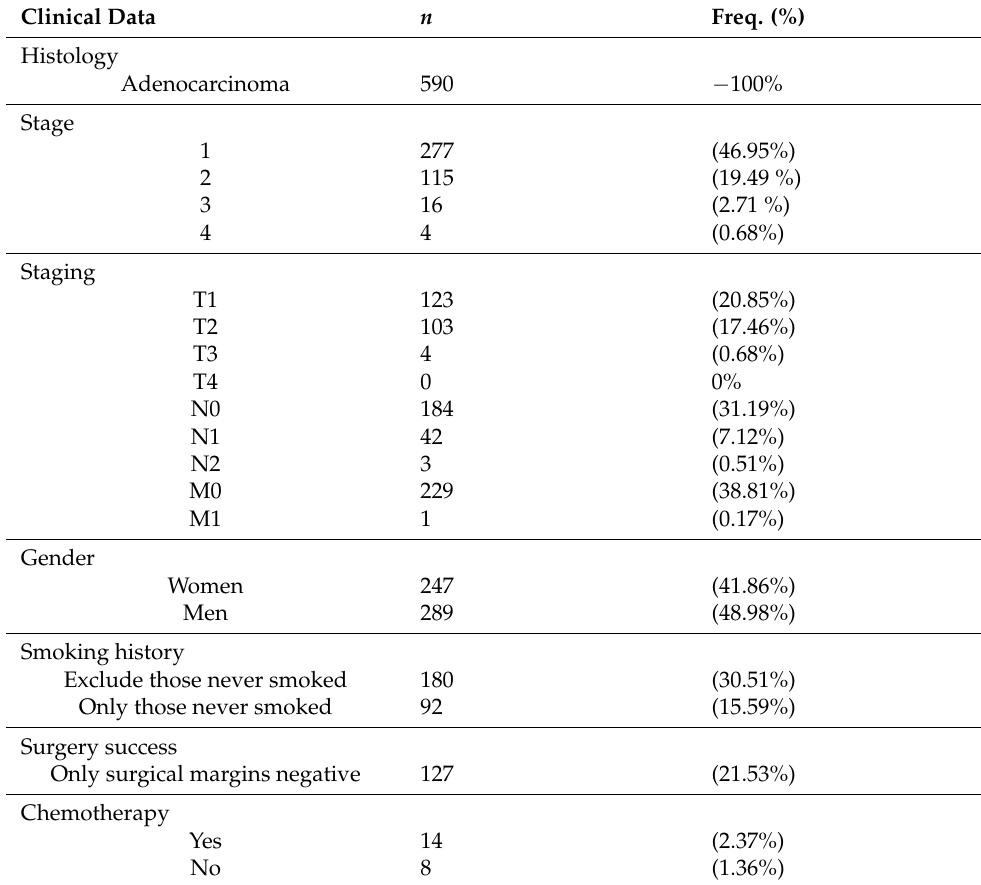
Table 2. Clinical data from 590 patients with adenocarcinoma evaluated for expression of epigenetic targets with the Kaplan-Meier